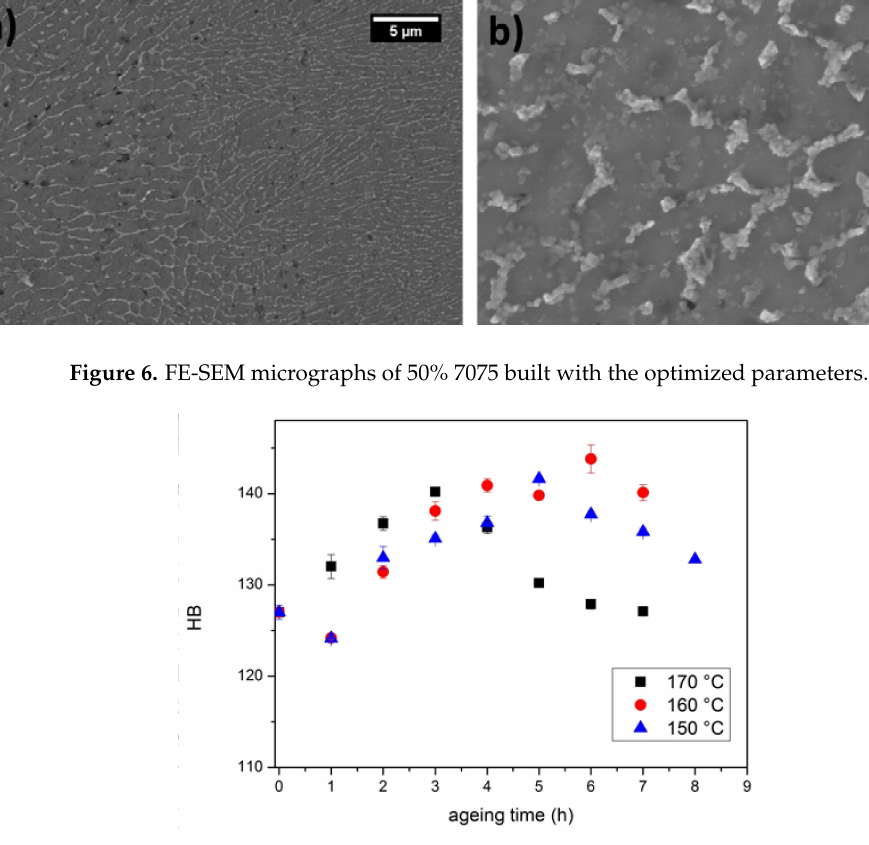
Figure 7. Brinell hardness as a function of the ageing